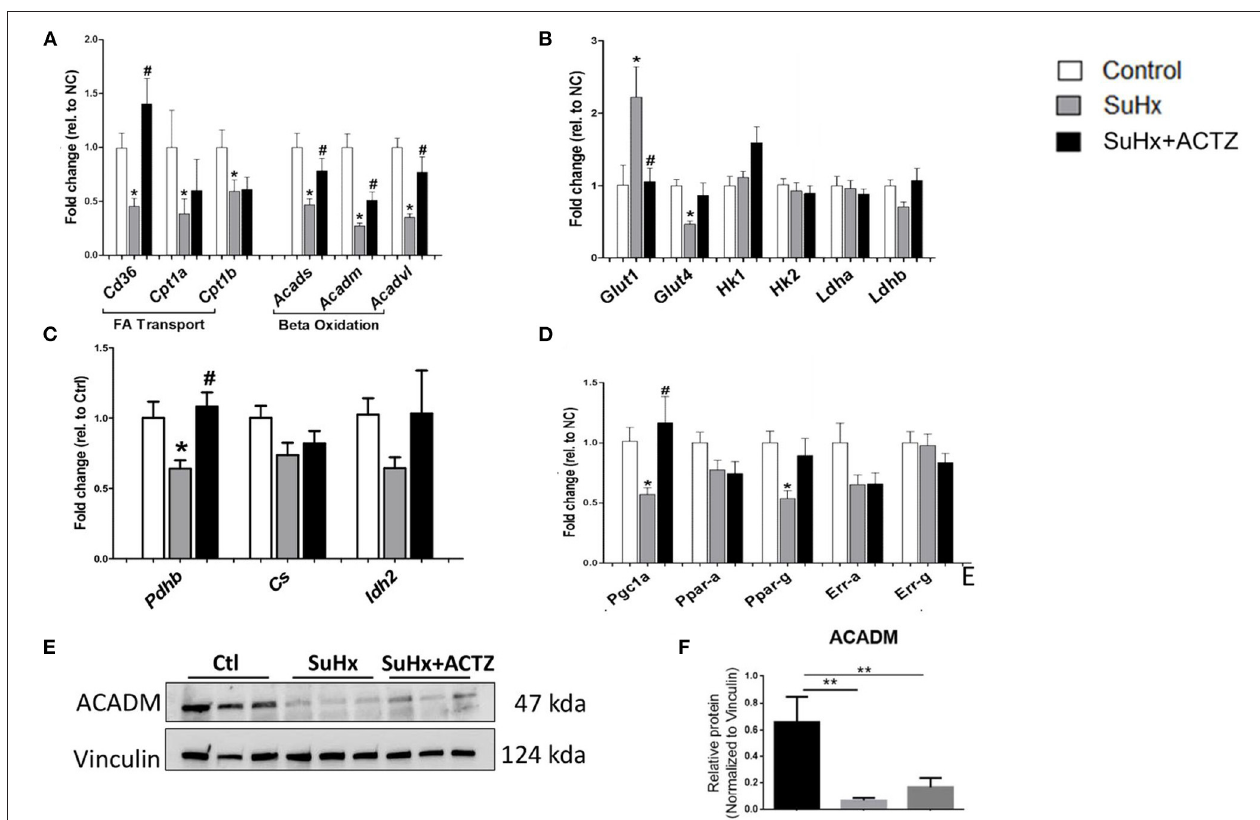
FIGURE 7 | Effects of acetazolamide (ACTZ) treatment on right ventricular (RV) metabolism associated markers in Sugen 5416/hypoxia (SuHx) animals. (A) Fatty acid transport and oxidation transcripts. (B) Glucose uptake and glycolysis markers. (C) Tricarboxylic acid cycle enzymes. (D) Mitochondrial transcription factors. (E) Representative immunoblots for beta oxidation enzyme medium-chain specific acyl-CoA dehydrogenase (ACADM) and (F) quantitative analysis of ACADM protein levels in the three experimental groups ( n = 3 per group). Experimental groups: Control, SuHx, and SuHx + ACTZ. Statistical analysis by one-way ANOVA and Tukey’s post-hoc test. Error bars are mean ± SEM (* P < 0.05, ** P < 0.01 compared to control, and # P < 0.05 compared to